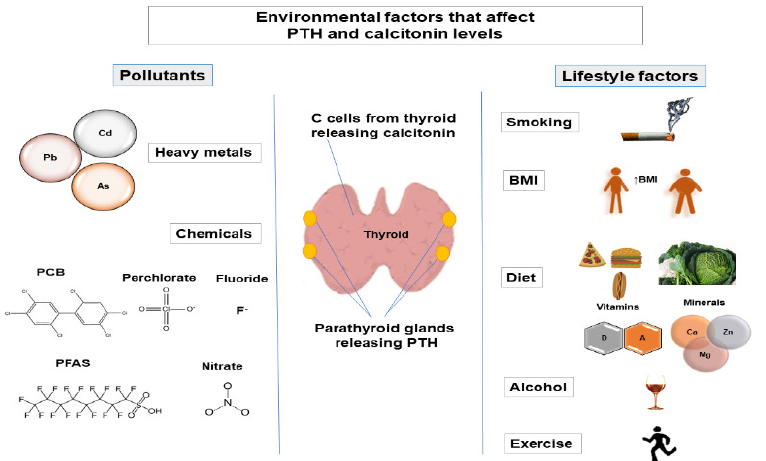
Figure 1. Environmental factors (lifestyle factors and pollutants) that affect PTH and calcitonin levels. As, arsenic; BMI, body mass index; Ca, calcium; Cd, cadmium; F, fluoride; Mg, magnesium; Pb, lead; PCB, polychlorinated biphenyl; PFAS, perfluoroalkyl substances; PTH, parathyroid hormone; Zn, zinc.